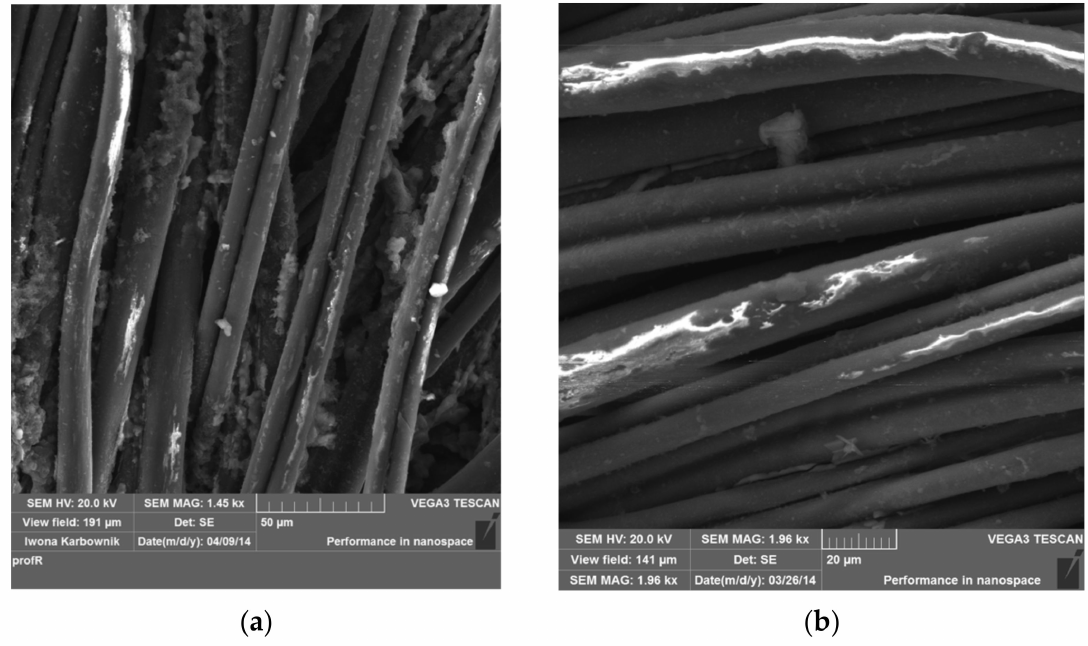
Figure 4. SEM images of: ( a ) One layer of PANI; ( b ) one layer of PPy inkjet printed on PAN substrate.